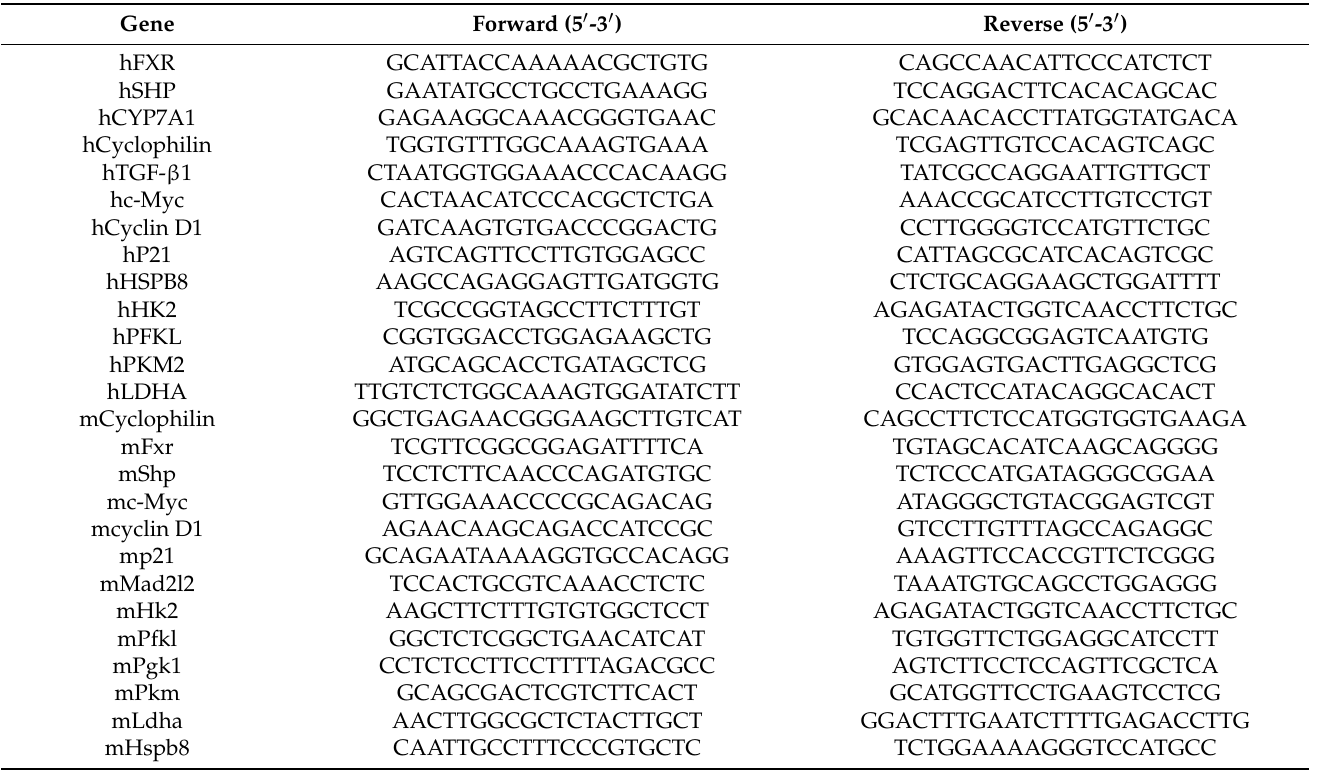
Table 1. List of primers used for quantitative real-time PCR